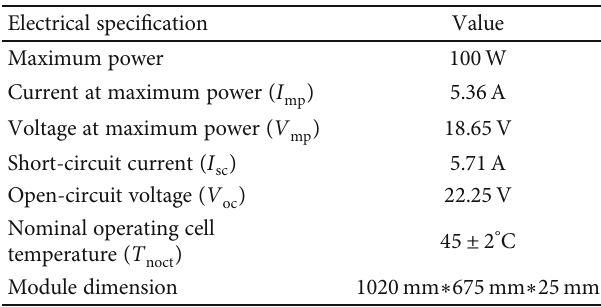
Table 1: PV module technical